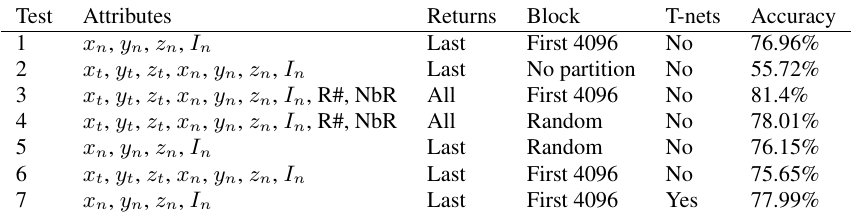
Table 1: Results obtained on the urban dataset. Column block and alignment indicate how blocks were built and whether alignment using the T-Nets was done. Point selection indicates how points were selected to build blocks.